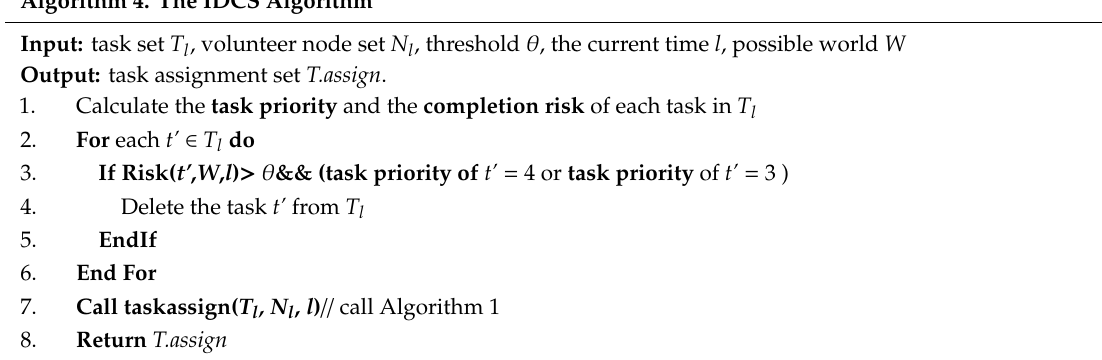
Algorithm 4. The IDCS